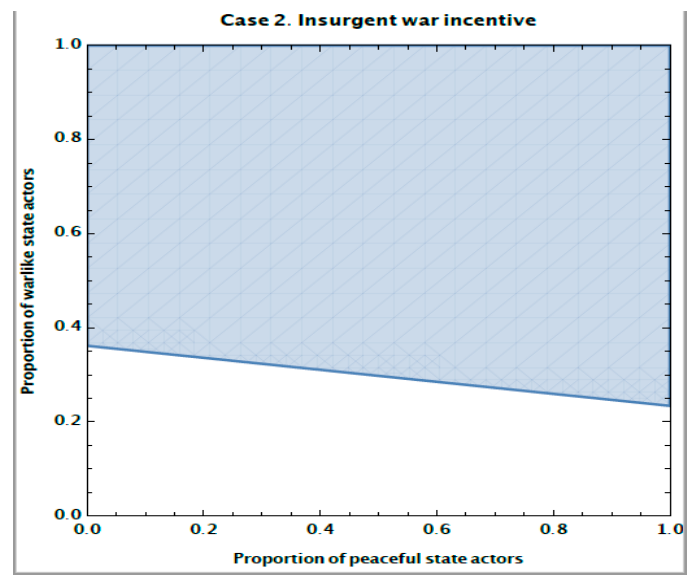
Figure 3. Fitness for Insurgents when r = 0.9, δ = 0.1, c = 0.2, and p = 0.5.